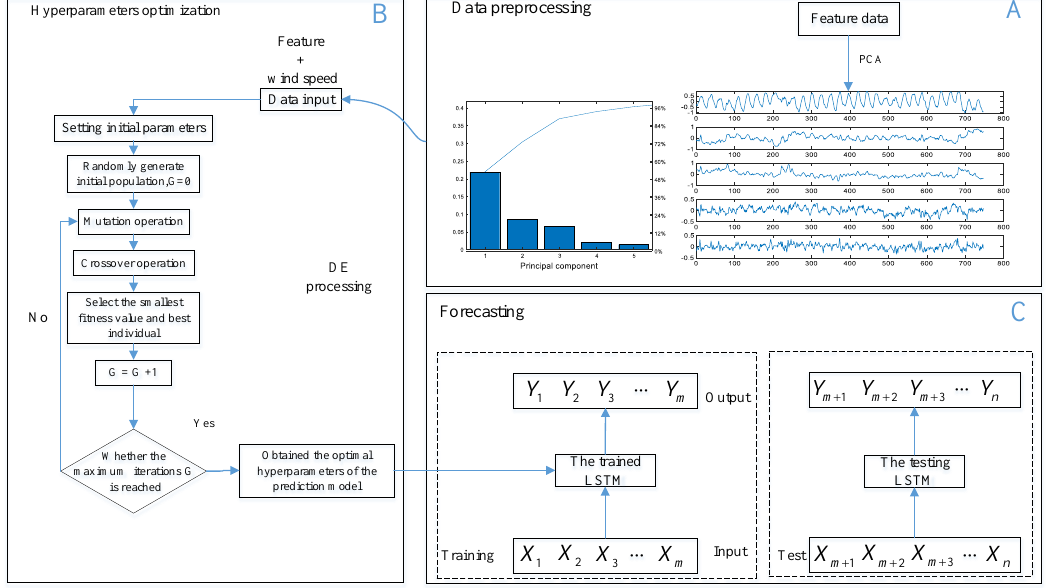
Figure 3. The proposed prediction framework.